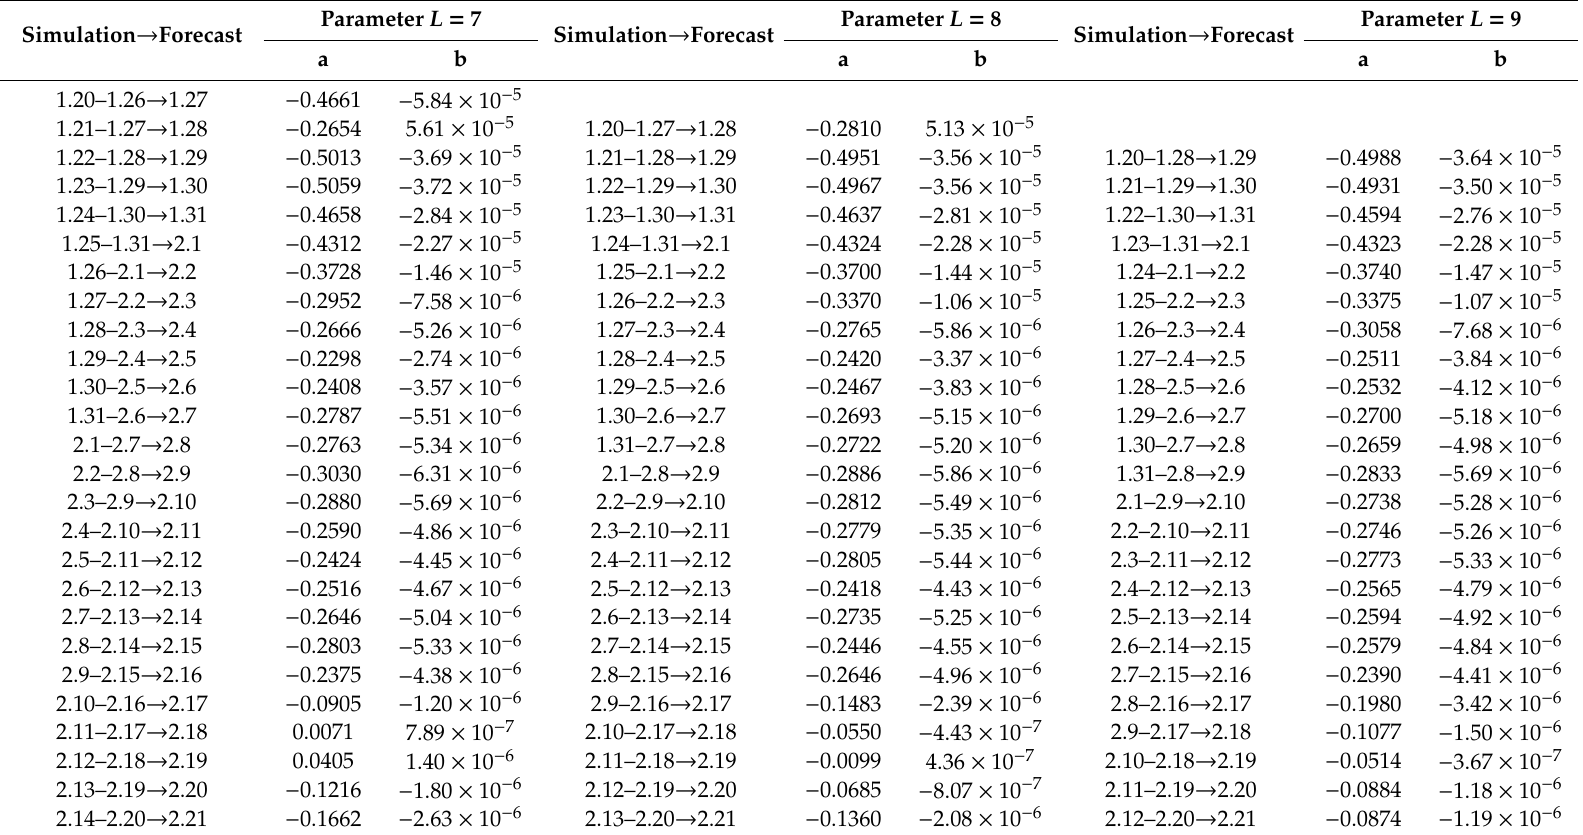
Table 2. The parameter values of the rolling grey Verhulst